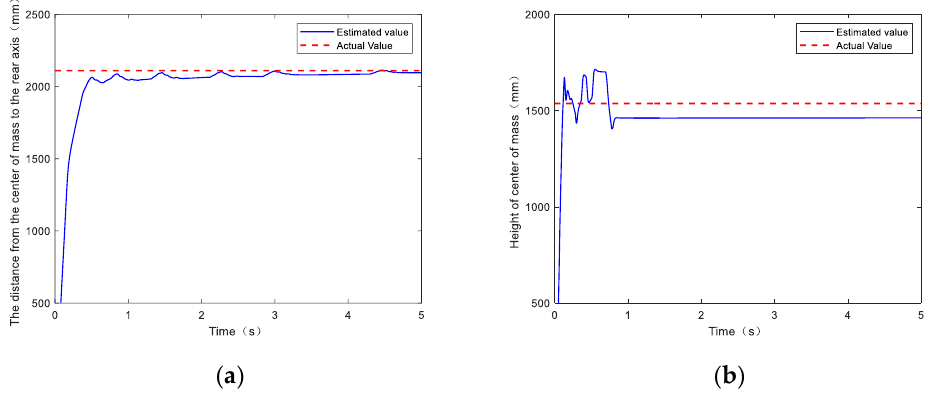
Figure 7. Estimation results of the center of gravity position of the vehicle without a load. ( a ) Dis- tance from the center of gravity position to the rear axis; ( b ) height of the center of gravity.